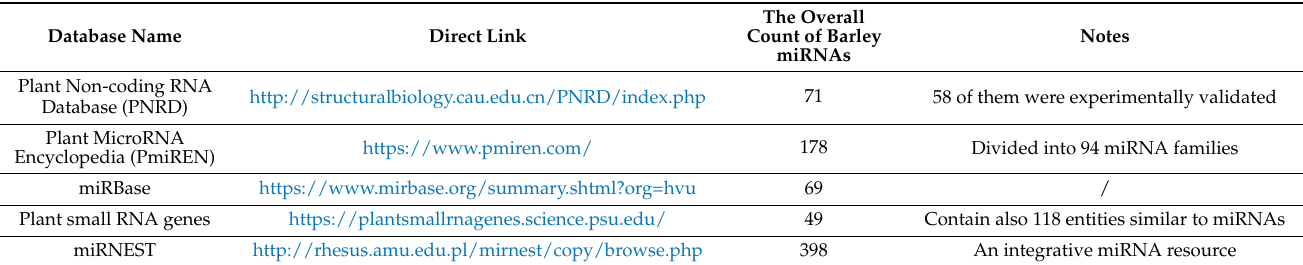
Table 2. User-friendly online databases comprising barley